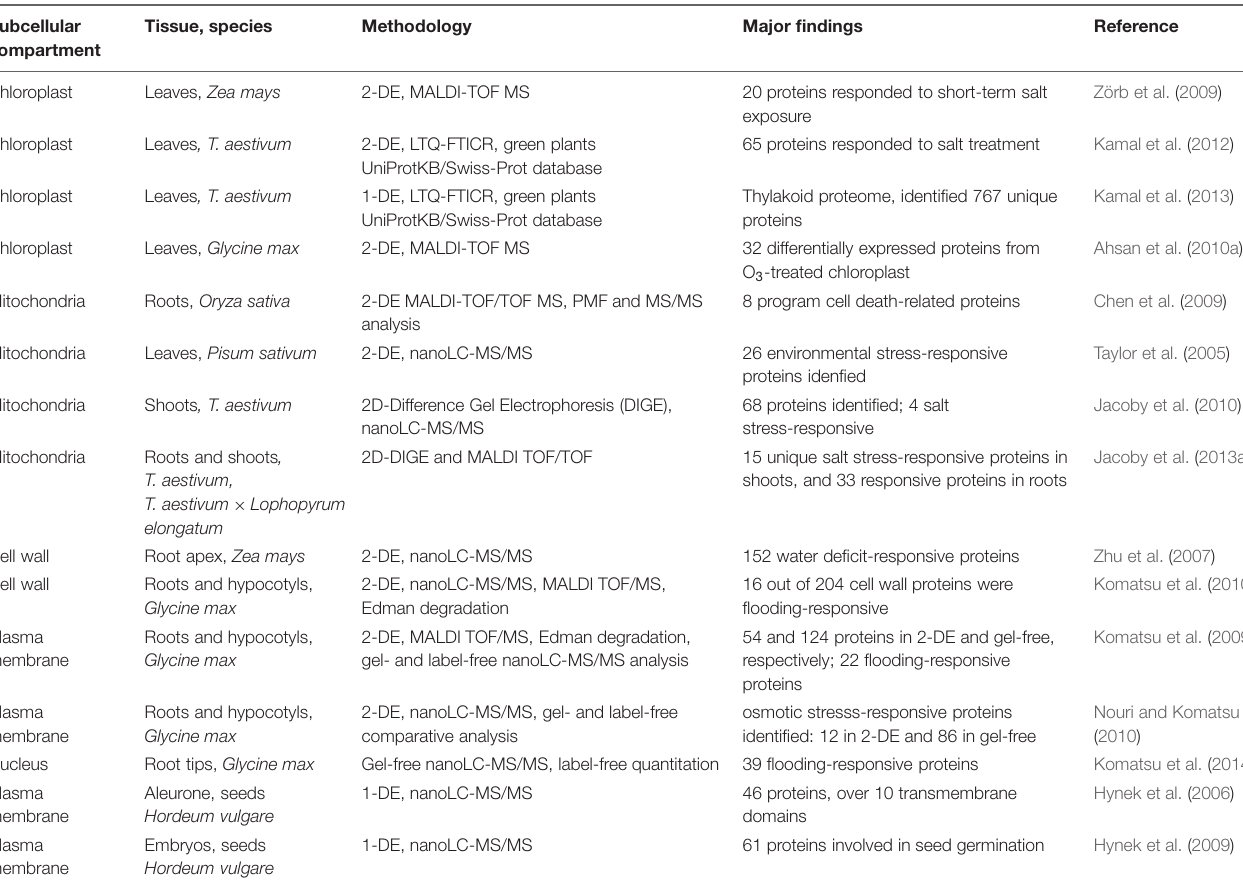
TABLE 1 | Overview of approaches used for subcellular proteomic studies in crop plants under abiotic stress. Subcellular